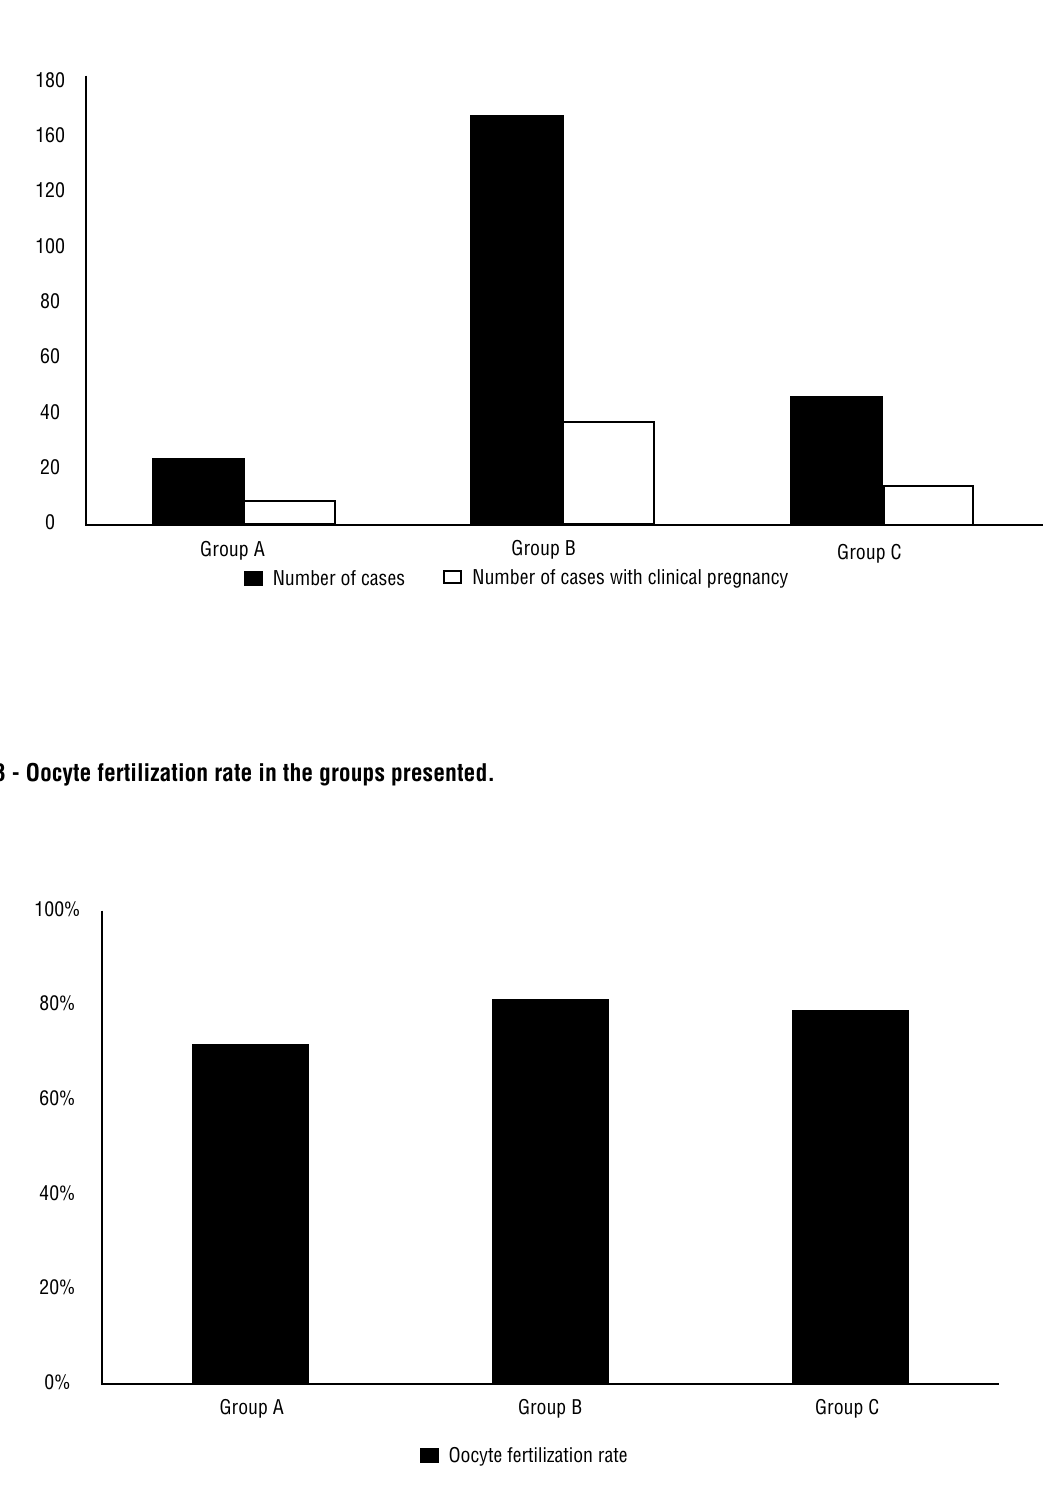
Figure 2 - Number of cases and number of cases with clinical pregnancy in the groups presented.